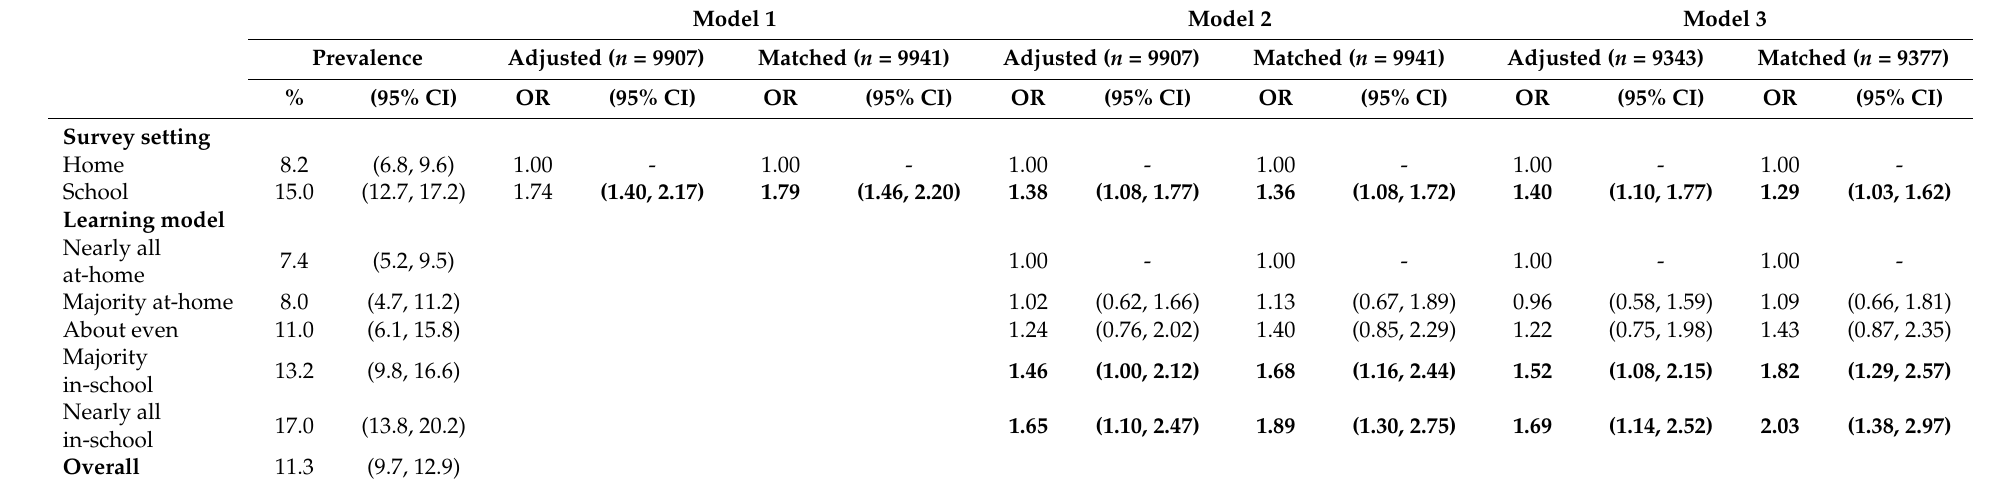
Series linearization, accounting for the complex sampling